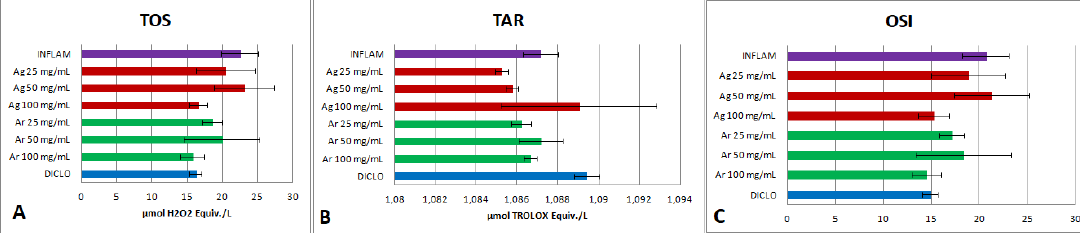
Figure 2. Oxidative stress tests. A . Total oxidative status (TOS). B . Total antioxidant response (TAR).